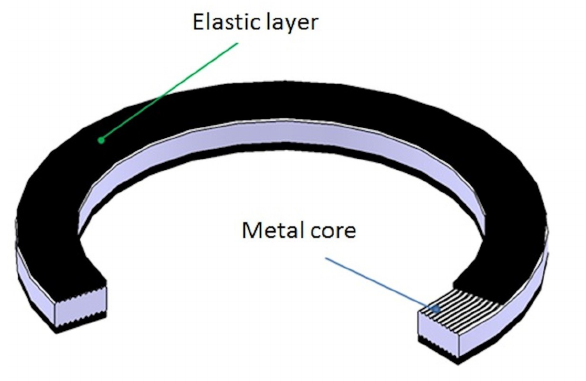
Figure 1: The exemplary solution of the camprofile gasket